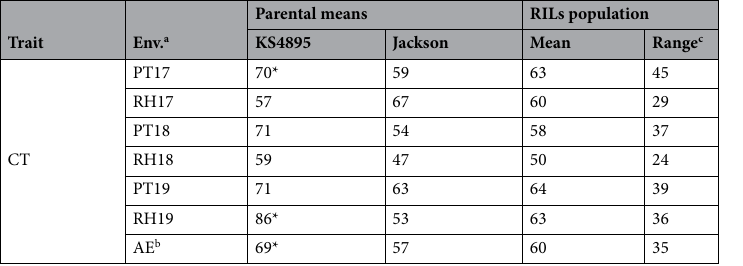
Table 2. A summary statistic of canopy temperature (CT) in the parents (KS4895 and Jackson) and RILs (n = 168) population of KS4895 and Jackson evaluated at Pine Tree and Rohwer in 2017, 2018 and 2019. *Indicated significant difference ( P ≤ 0.05) between parents. a Environments: Prefixes PT and RH denotes Pine Tree and Rohwer, respectively followed by 17 (2017), 18 (2018), and 19 (2019) for years. b AE denotes averaged across environments. c Range of RIL population is the difference between maximum and minimum IR